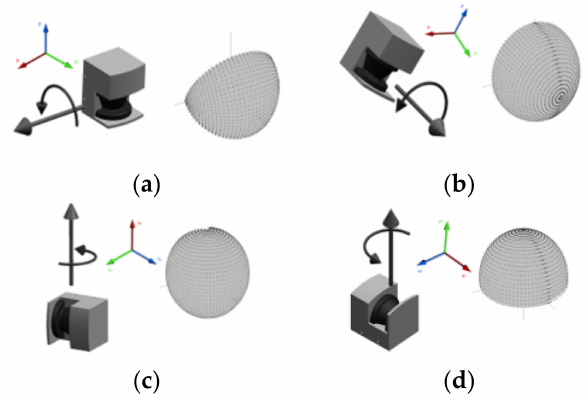
Figure 10. Electromechanical scanning configurations and its corresponding measurement density distribution; ( a ) pitching scan, ( b ) rolling scan, ( c ) yawing scan, ( d ) top yawing scan